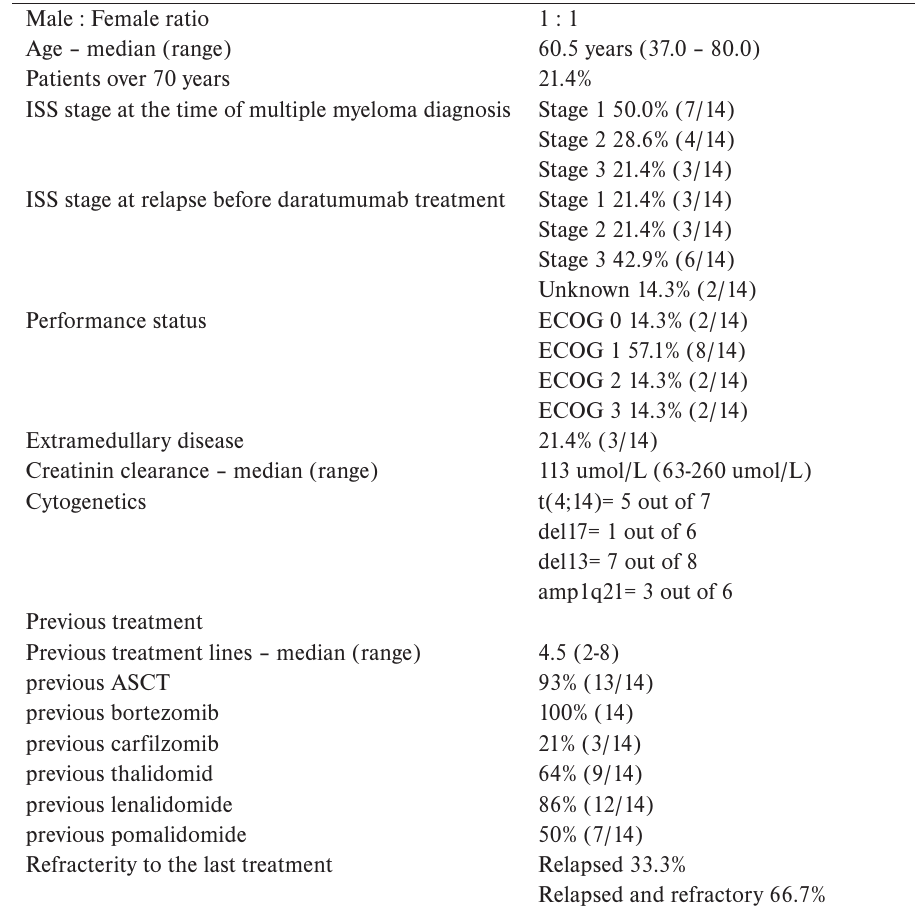
Table 1. Basic demographics and group characteristics.